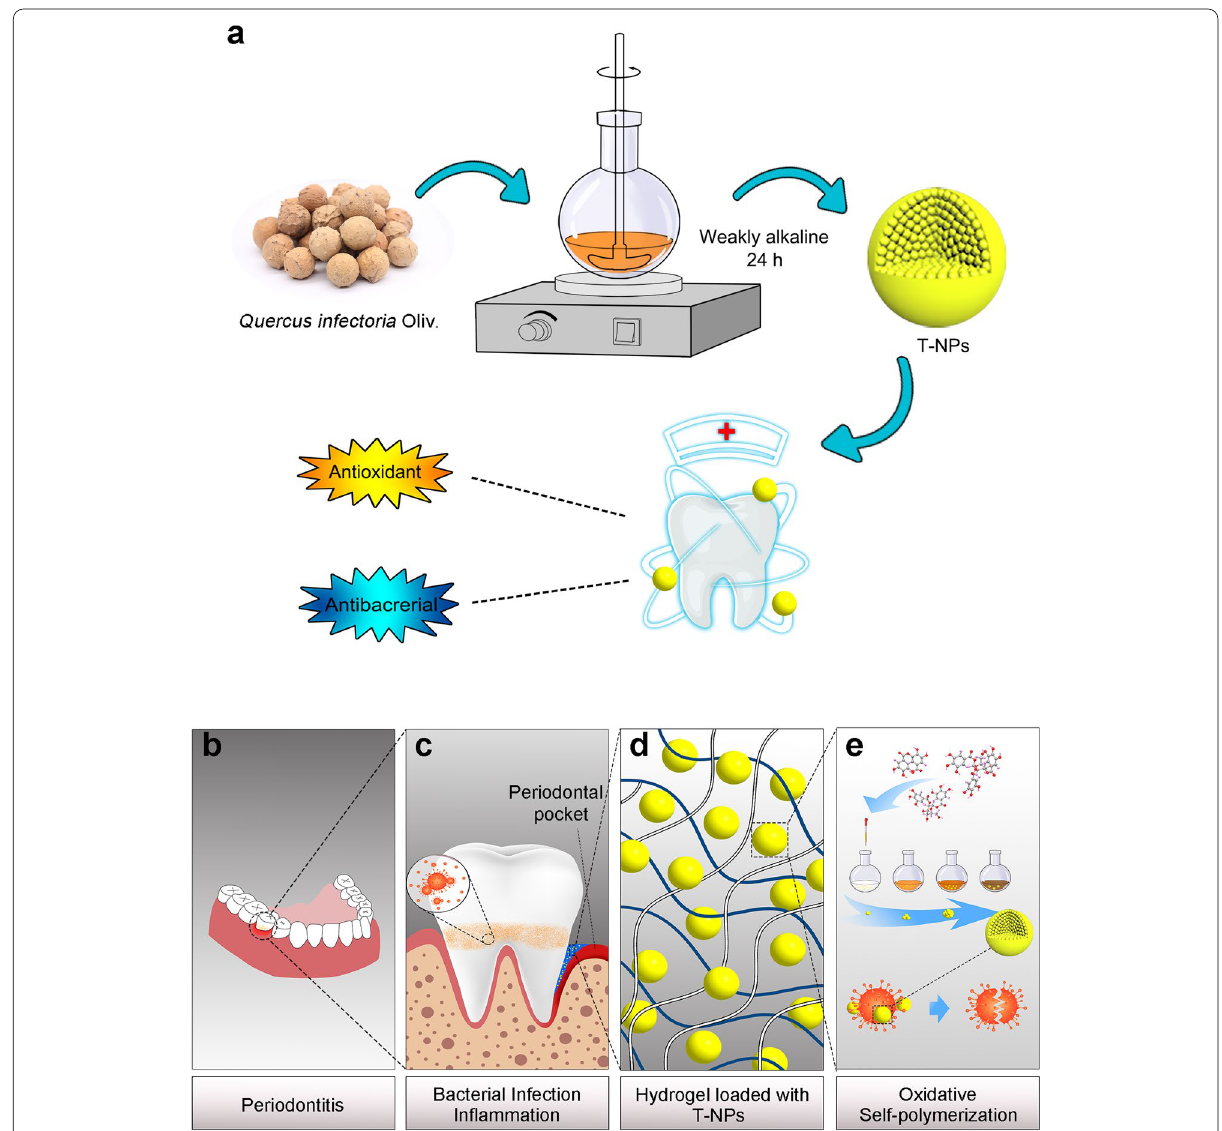
Fig. 1 Formation of Turkish Galls effective constituent (TGEC) nanoparticles and preparation of the smart hydrogel loaded with T-NPs for potential application in periodontitis. a Formation of TGEC nanoparticles and their antioxidant and antibacterial activity in periodontitis. b Schematic representation of periodontitis. c Anaerobic bacteria colonize the anaerobic periodontal pocket, which contributed to oral infection and possible results in periodontitis. d The smart hydrogel loaded with T-NPs. e Preparation of T-NPs by oxidative polymerization, and it exhibited high antibacterial